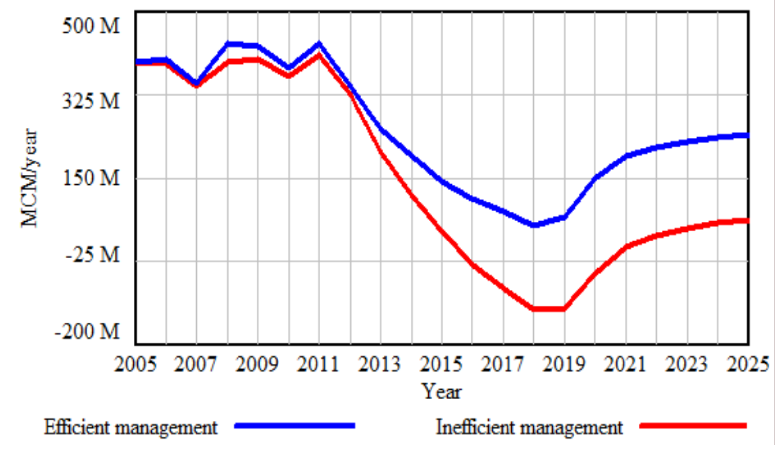
Figure 15. Combining different scenarios.